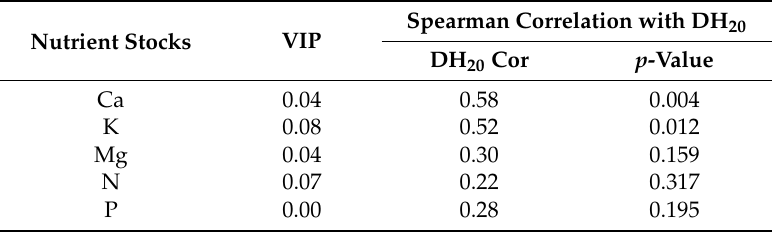
Table 7. Relationships between dominant height of trees (DH 20 ) and the short to medium term available nutrient stocks (organic layer and mineral soil down to 60 cm depth). Values correspond to the Spearman correlation coefficients (rho) and their associated p -values (VIP: Variable influence in Projection from the